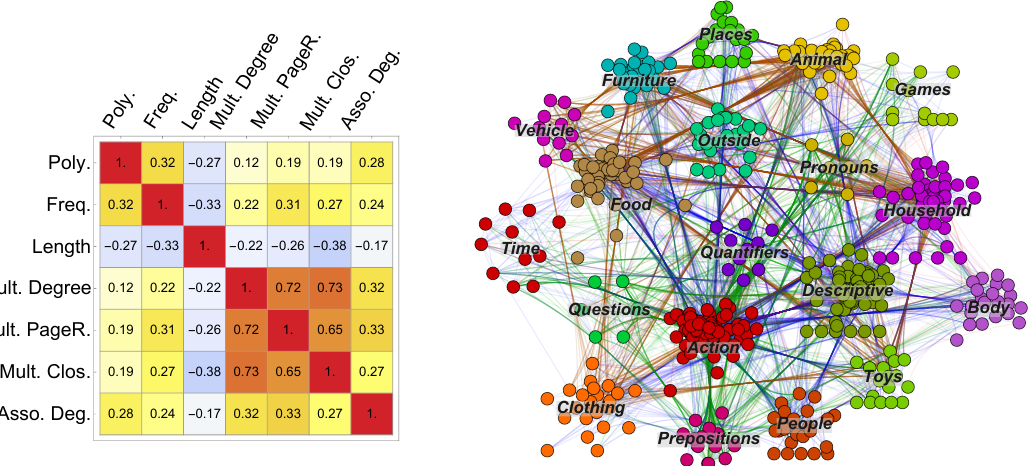
Figure 2. Right: visualisation of the multiplex lexical network of normative learners at age 30 months. Links are coloured according to their type (free associations in blue, co-occurrences in green, feature sharing links in brown and phonological similarities in red). Nodes represent words and are clustered in categories according to the Communicative Development Inventory classification. Left: heat map of Kendall tau correlations between psycholinguistic and network features of words. Red (blue) indicates fully positive (negative) correlation. All correlations with a Kendall tau | τ | > 0.05 were found to be statistically significant in a Kendall tau test at a 0.01 significance